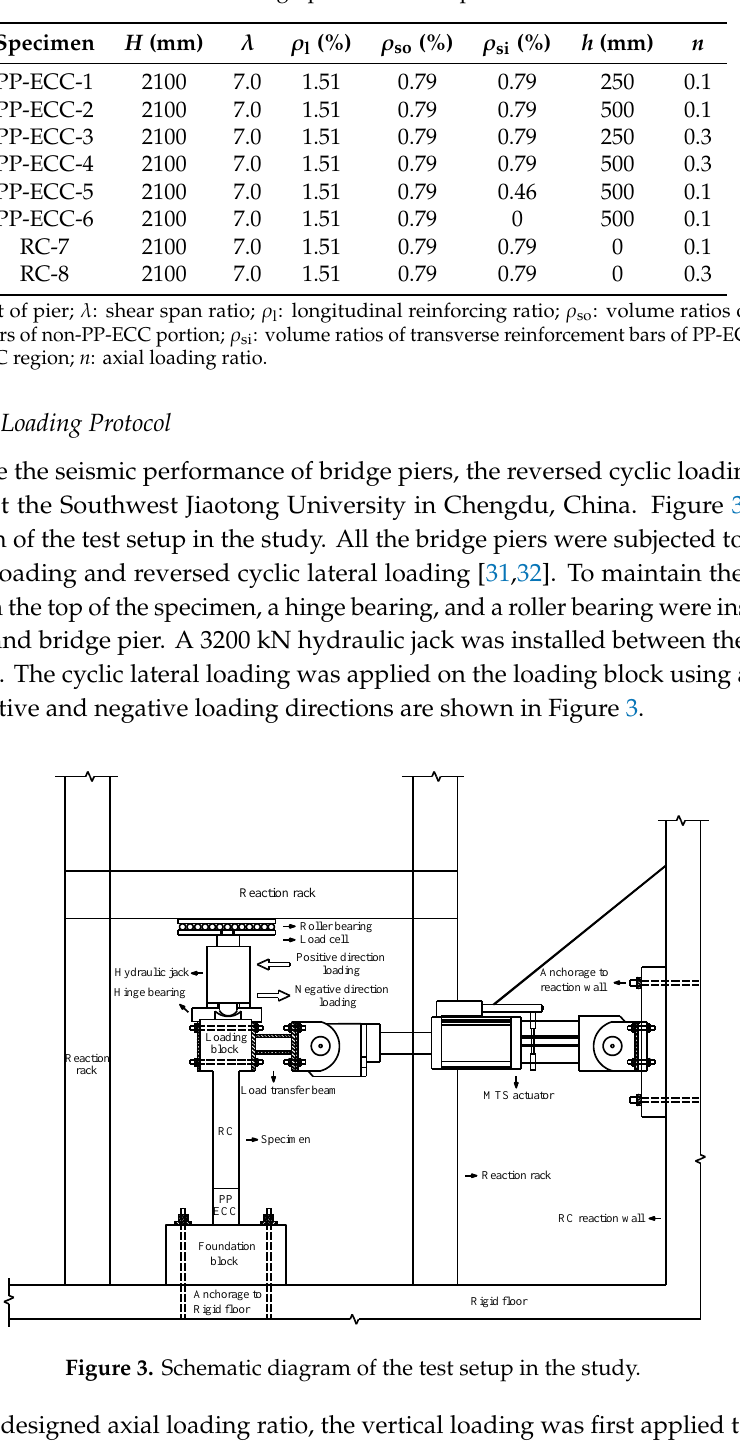
Figure 4. Reversed cyclic lateral loading protocol in the study. Reinforced concrete bridge piers bend and deform under the combined lateral and vertical loadings. The curvature performance is commonly used to evaluate the rotation capacity or the variation of rotation at different heights of the bridge pier. A single or double curvature that strongly depends on the end moments and end forces may be acted in a pier. The curvature of a cross-section can be calculated from the strain on both sides of the member and the distance between two edges. Then, the bending moment-curvature curve of the whole member can be obtained from several sections. Alternatively, the vertical displacements of both sides can also be used to calculate the curvature. As illustrated in Figure 5a, three curvature measurement rods and three pairs of cable- extension transducers were installed at the plastic hinge region. The transducer pairs were 15, 30, and 60 cm from the bottom of the pier, and defined as: (left side) ZL-1, ZL-2, ZL-3 and (right side) BL-1, BL-2, BL-3. Figure 5b shows the schematic diagram of curvature calculation at each cross-section of bridge pier through Equation (1) [34]. 𝜑 = 𝜃 𝐻 = 𝛥 ℎ 𝐵𝐻 = | ℎ 1 | + | ℎ 2 | 𝐵𝐻